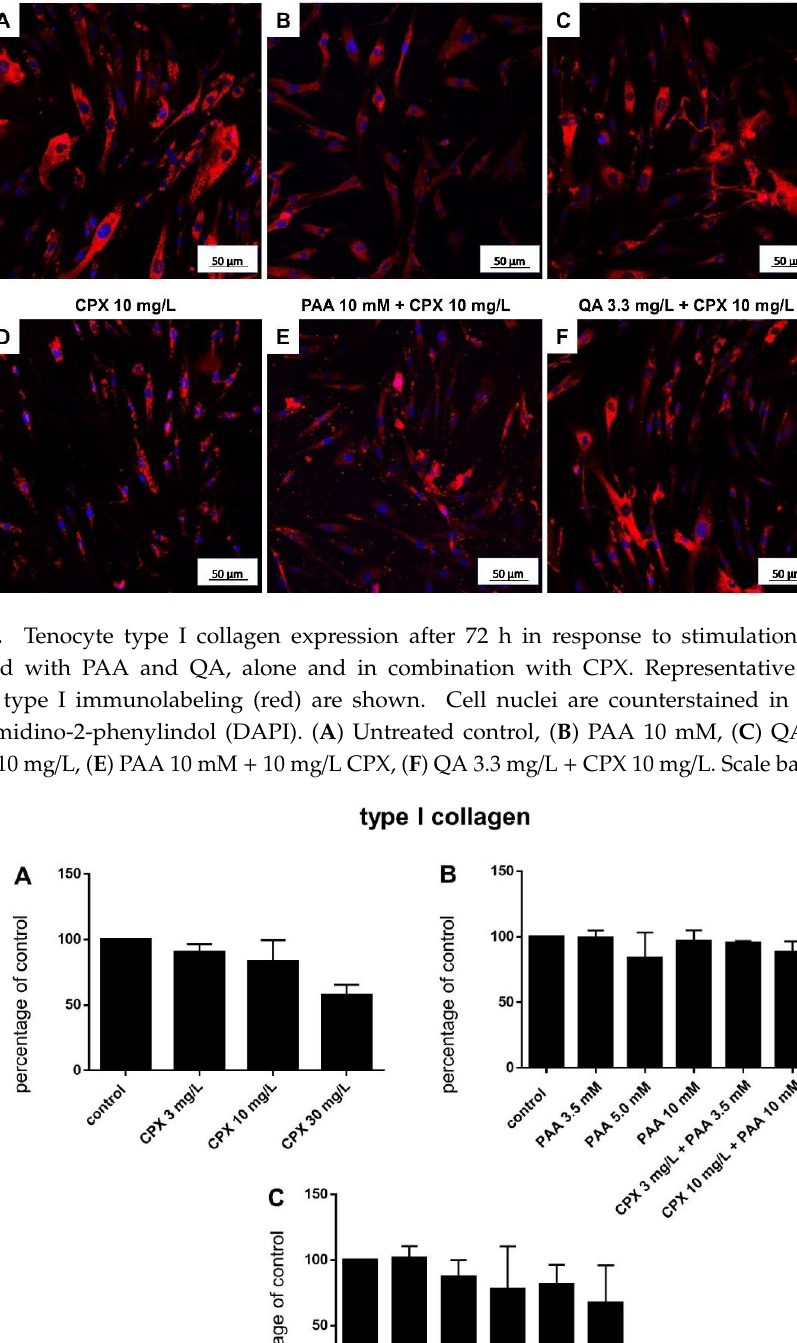
Figure 8. Type I collagen and β1-integrin expression of tenocytes treated with ciprofloxacin as shown by Western blot analysis and densitometric evaluation after 72 h. ( A ) Representative Western blot of type I collagen expression, ( A1 ) densitometric evaluation of the type I collagen Western blots. ( B ) Representative Western blot of β1-integrin expression. The two visible bands (hyperglycosylated and hypoglycosylated forms ( B1 , A2 )) of the β1-integrin were densitometrically evaluated in the Western blots performed for β1-integrin detection. Collagen type I, n = 4: β1-integrin, n = 5: Collagen type I.